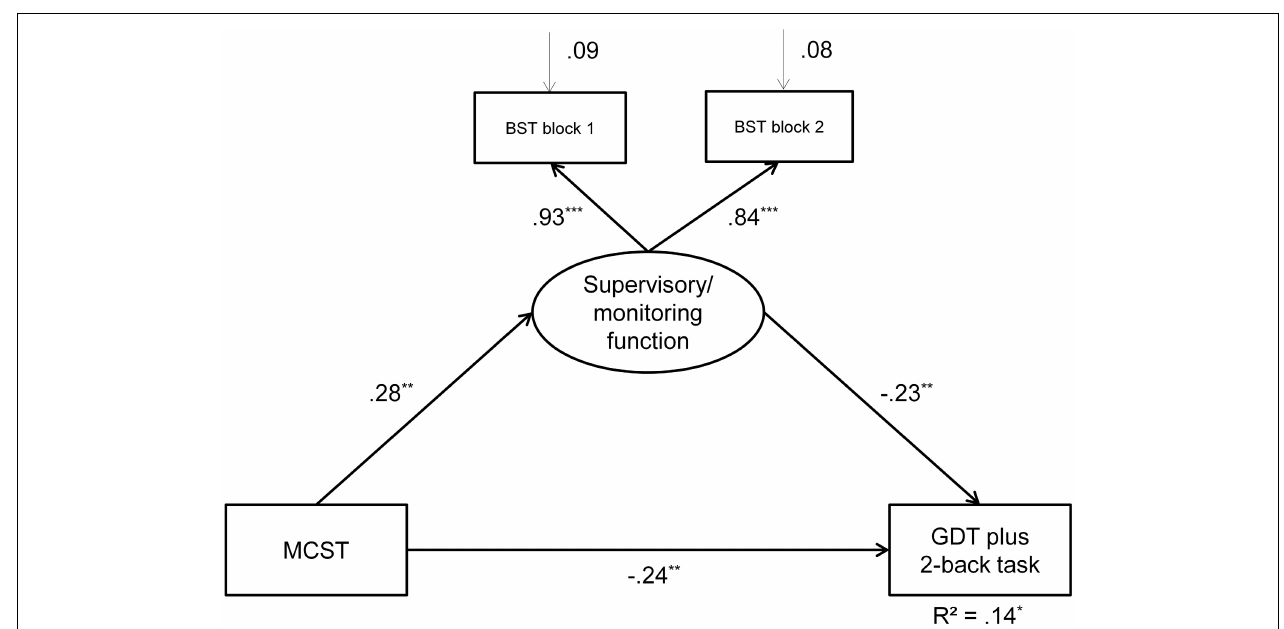
FIGURE 3 | The full structural equation model. The oval shape indicates the latent dimension while the rectangular shapes indicate the manifest variables. Bold arrows indicate direct effects while the non-bold arrows display errors. ∗∗∗ p ≤ 0 . 001, ∗∗ p ≤ 0 . 001, ∗ p ≤ 0 . 050. BST, Balanced